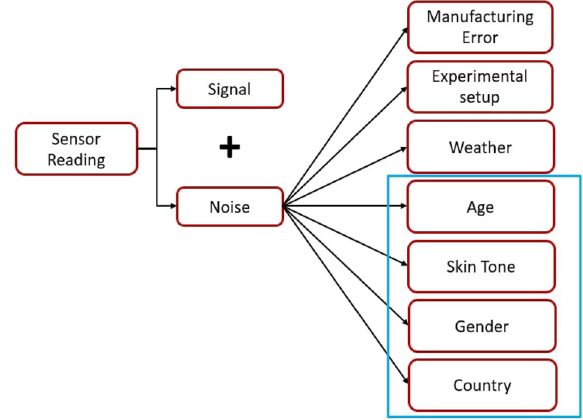
Fig. 5 Sources of noise in the measured signal, highlighting the sources covered in this study. The variation of heart rate measured with rPPG methods across the demographic factors of age, skin tone, gender and country of origin, is analyzed using statistical hypothesis